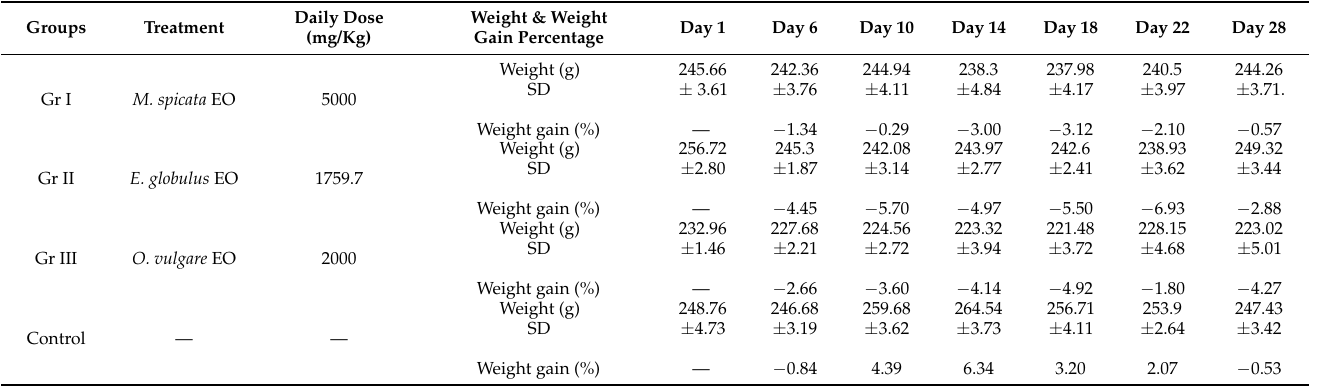
Table 5. Body weight (g) of rats treated with essential oils of M. spicata , E. globulus, and O. vulgare for 28 days and percentage of weight gain